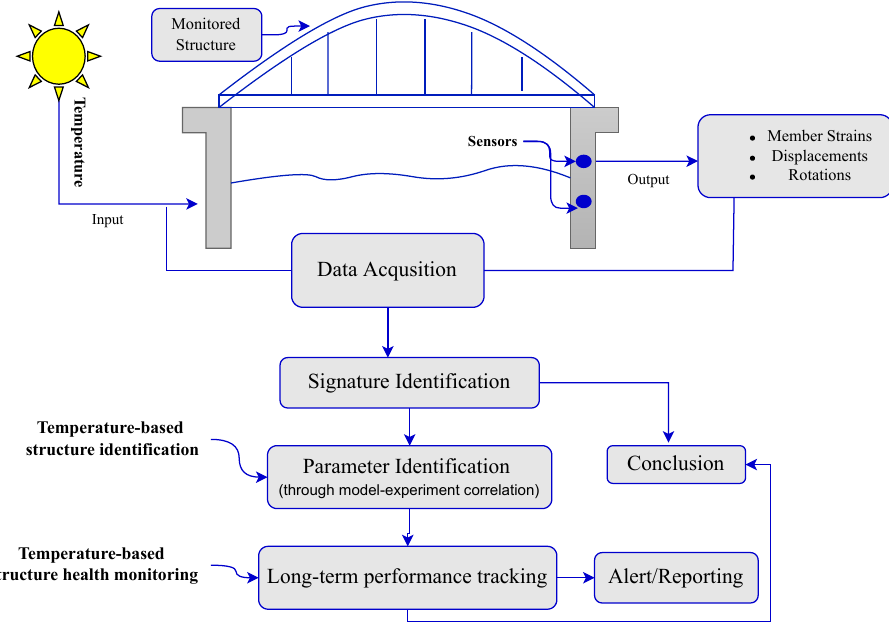
Figure 6. SHM system based on TBSI